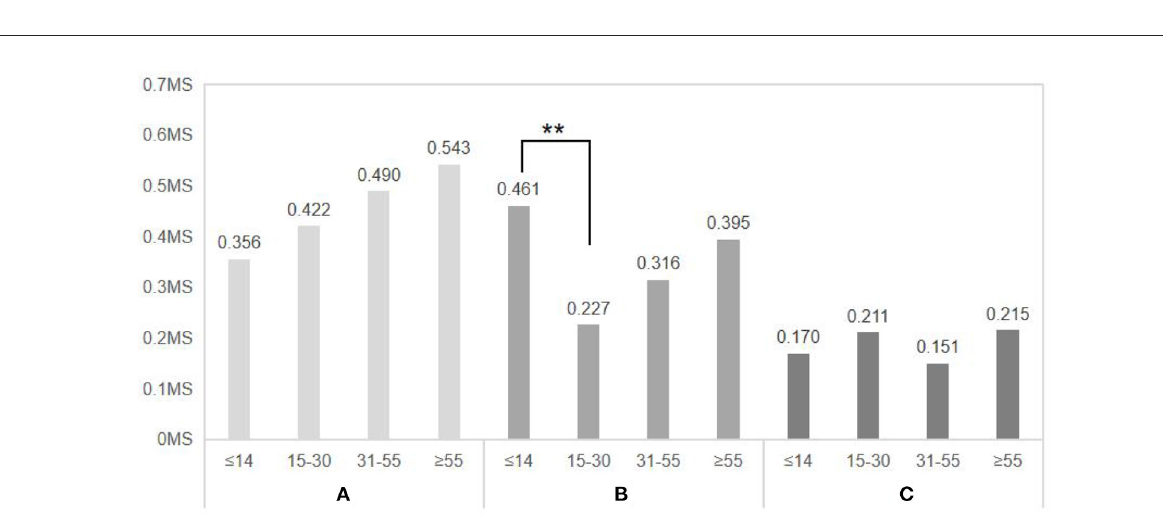
that women are more happy with green space (50). Asa et